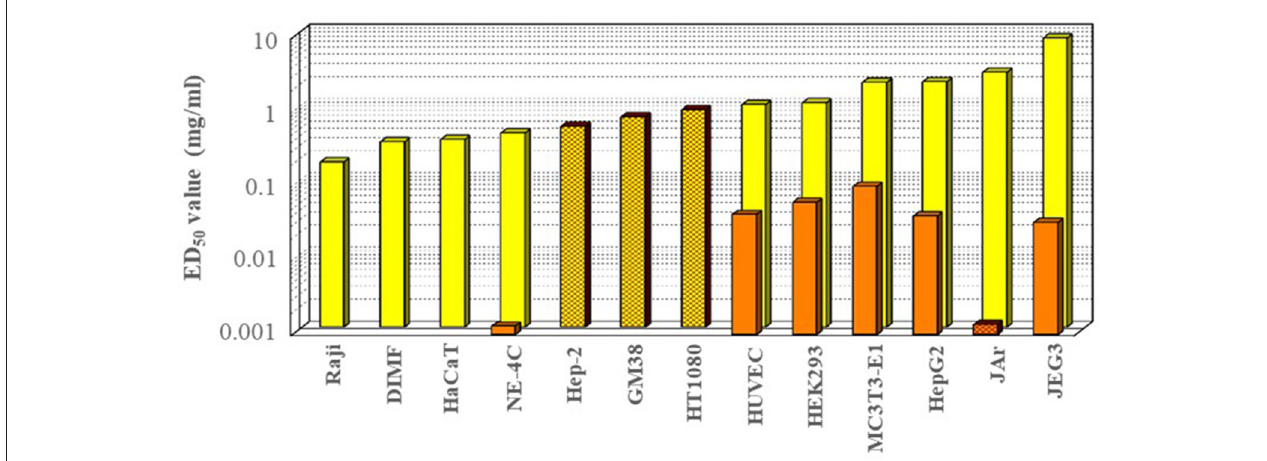
FIGURE 3 | In vitro cytotoxicity of glyphosate ( light columns ) and its formulated preparation Roundup ® ( dark columns ) on various cell lines Raji: human hematopoietic Raji (Epstein-Barr virus transformed human lymphocyte) cells ( Townsend et al., 2017), DIMF, diploid fin cell line from the Oriental weather loach Misgurnus anguillicaudatus ( Qin et al., 2017); HaCaT, human epithelial keratinocyte cells (Elie-Caille et al., 2010); NE-4C, murine stem cell-like neuroectodermal cells (Székács et al., 2014); Hep-2, human epithelial type 2 (HeLa contaminant) cells (Mañas et al., 2009); GM38, human fibroblast cells (Monroy et al., 2005); HT1080, human fibrosarcoma cells ( Monroy et al., 2005); HUVEC, primary neonate human umbilical vein endothelial cells (Benachour et al., 2007; Benachour and Séralini, 2009; Gasnier et al., 2009); HEK293, embryonic kidney cells (Benachour et al., 2007; Benachour and Séralini, 2009; Gasnier et al., 2009; Mesnage et al., 2013a); MC3T3-E1, murine osteoblast precursor cells ( Farkas et al., 2018); HepG2, human hepatoma cells (Benachour et al., 2007; Benachour and Séralini, 2009; Gasnier et al., 2009 ); JAr, human chorioplacental cells (Young et al., 2015); JEG3, human choriocarcinoma cells (Benachour et al., 2007; Benachour and Séralini,